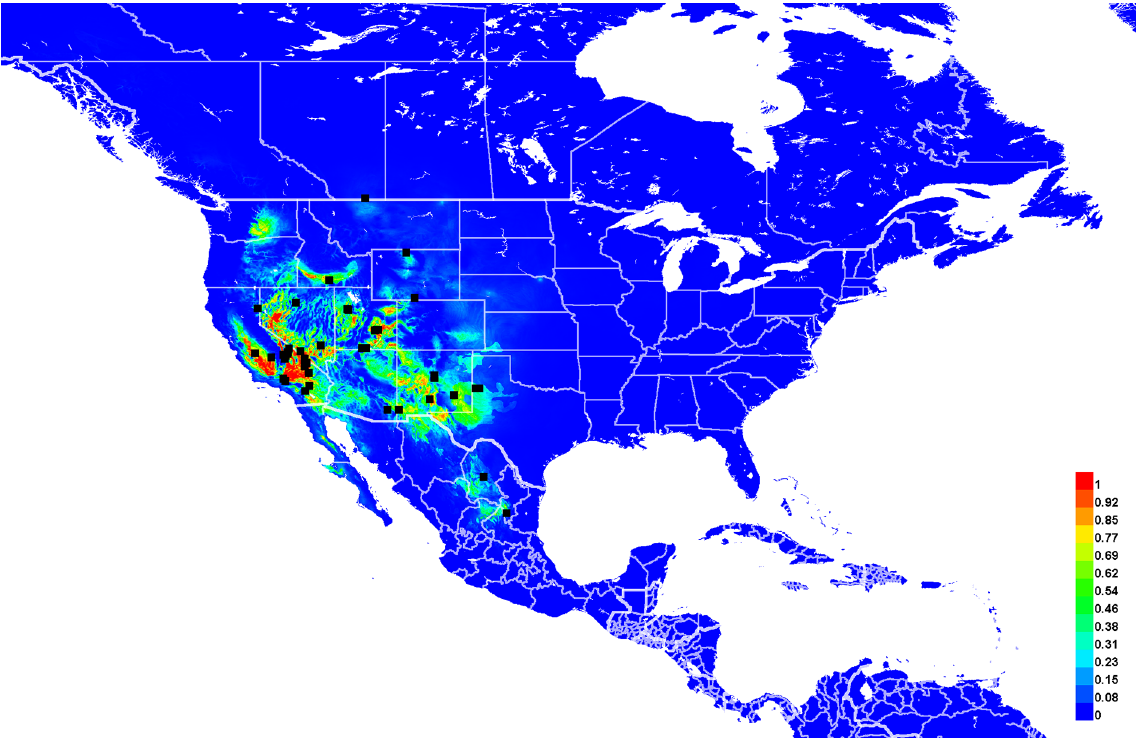
Fig. 69. Georeferenced collection records of Lasioglossum ( D. ) pallidellum (Ellis, 1914) (black squares) and predicted distribution by maximum entropy ecological niche modeling in Maxent (colour shading). Warmer colours indicate higher cloglog probability of